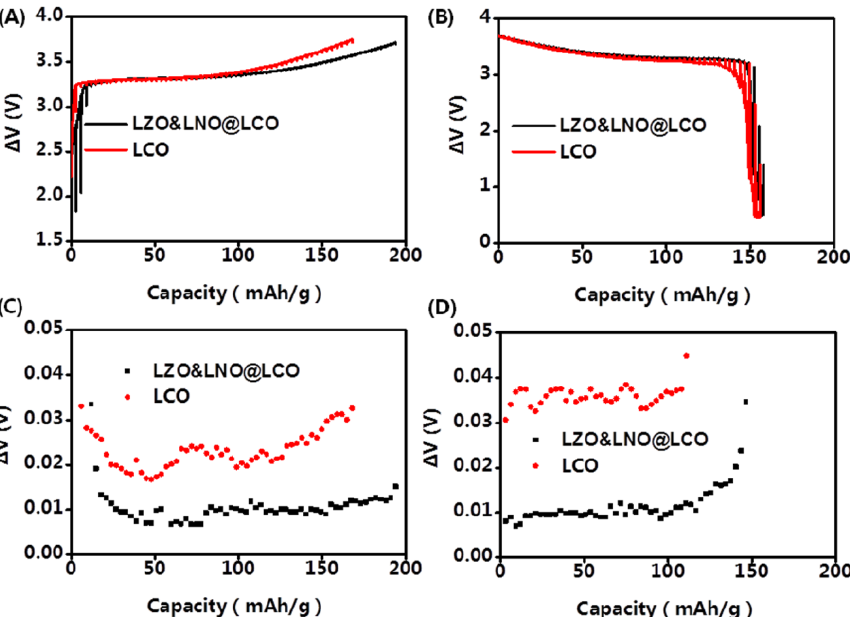
Figure 8. Charging GITT profiles ( A ) and discharging GITT profiles ( B ) of LLZO&LNO@LCO and LCO samples measured at the first cycle. Charging polarization voltage profiles ( C ) and discharging polarization GITT profiles ( D ) of LLZO&LNO@LCO and LCO samples measured at the first cycle.